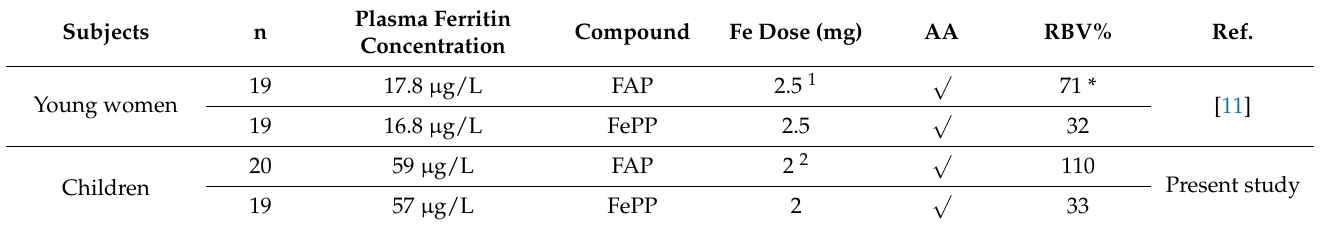
Table 3. Relative iron bioavailability (RBV) for ferrous ammonium phosphate (FAP) and ferric pyrophosphate (FePP), to that from ferrous sulfate (FeSO 4 ), in reconstituted milk determined using the erythrocyte stable isotope incorporation